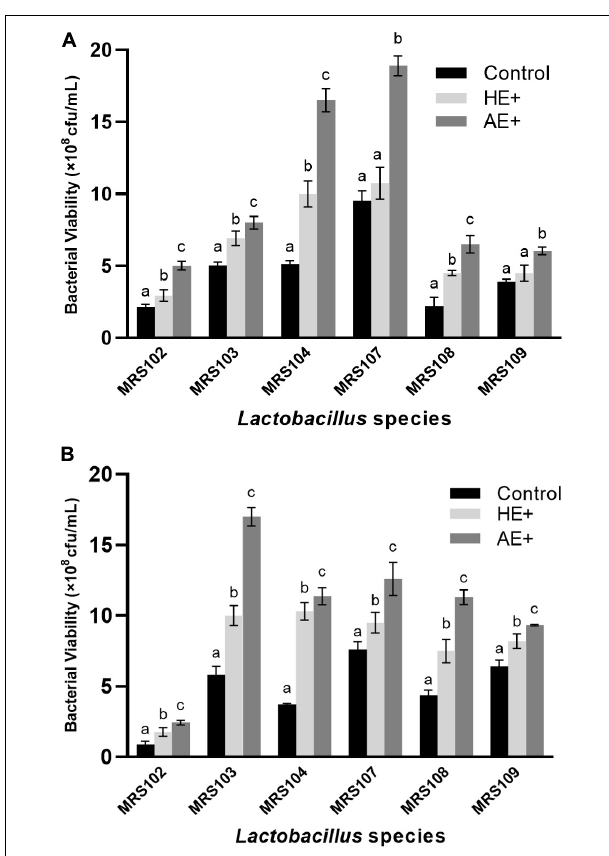
FIGURE 1 | The counting of viable bacteria during logarithmic growth (A) and platform stages (B) of six selected Lactobacillus strains on the addition of Euglena powders (AE+ and HE+).